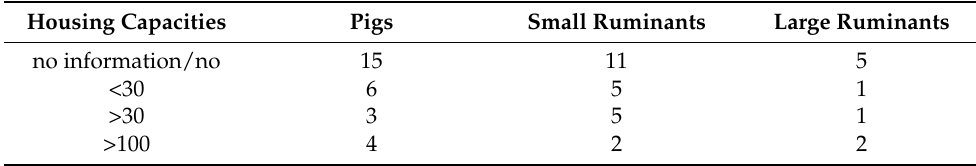
Table 2. Housing capacities. Housing capacities for the different farm animals; “no information” means that a question was not